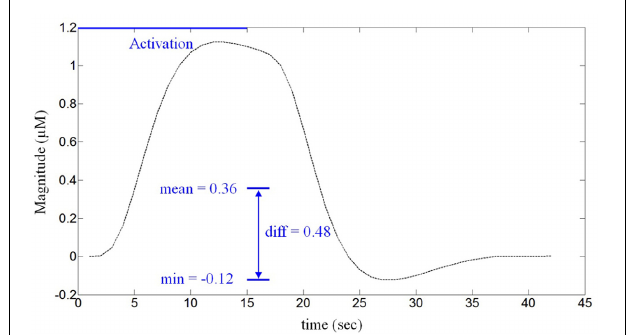
FIGURE 3 | The defined feature for classification. The difference between the mean and the minimum value of the HbO obtained from a 15s stimulus (in μ